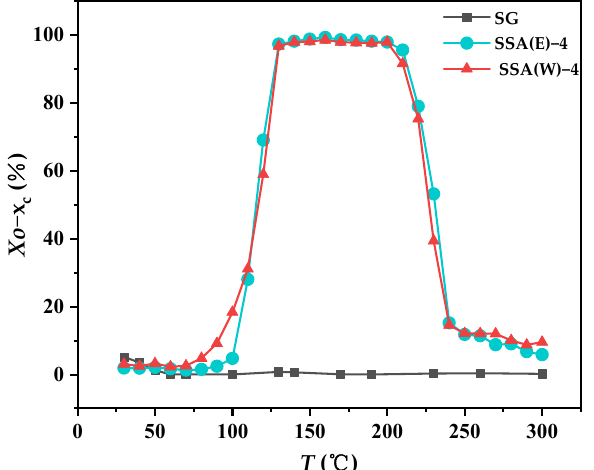
Figure 4. Plots of o -xylene removal ratios ( Xo -x c ) vs. temperature ( T ) for SG, SSA(E) − 4 and SSA(W) − 4.